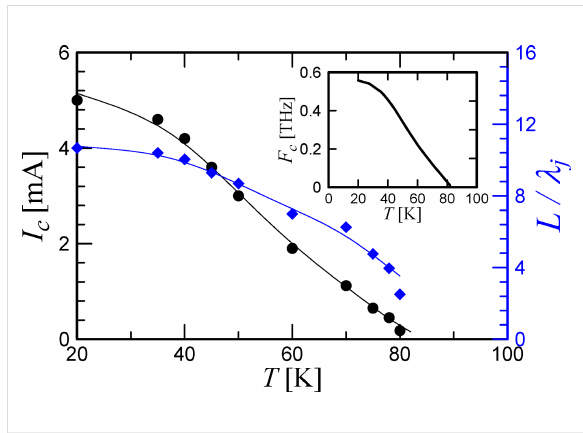
Figure 1: The dependence of the critical current (black dots) and the characteristic length of the Josephson junction (blue diamonds) on the temperature. The solid curves are spline approximations. The inset shows F c = ω c /(2 π ) versus T .